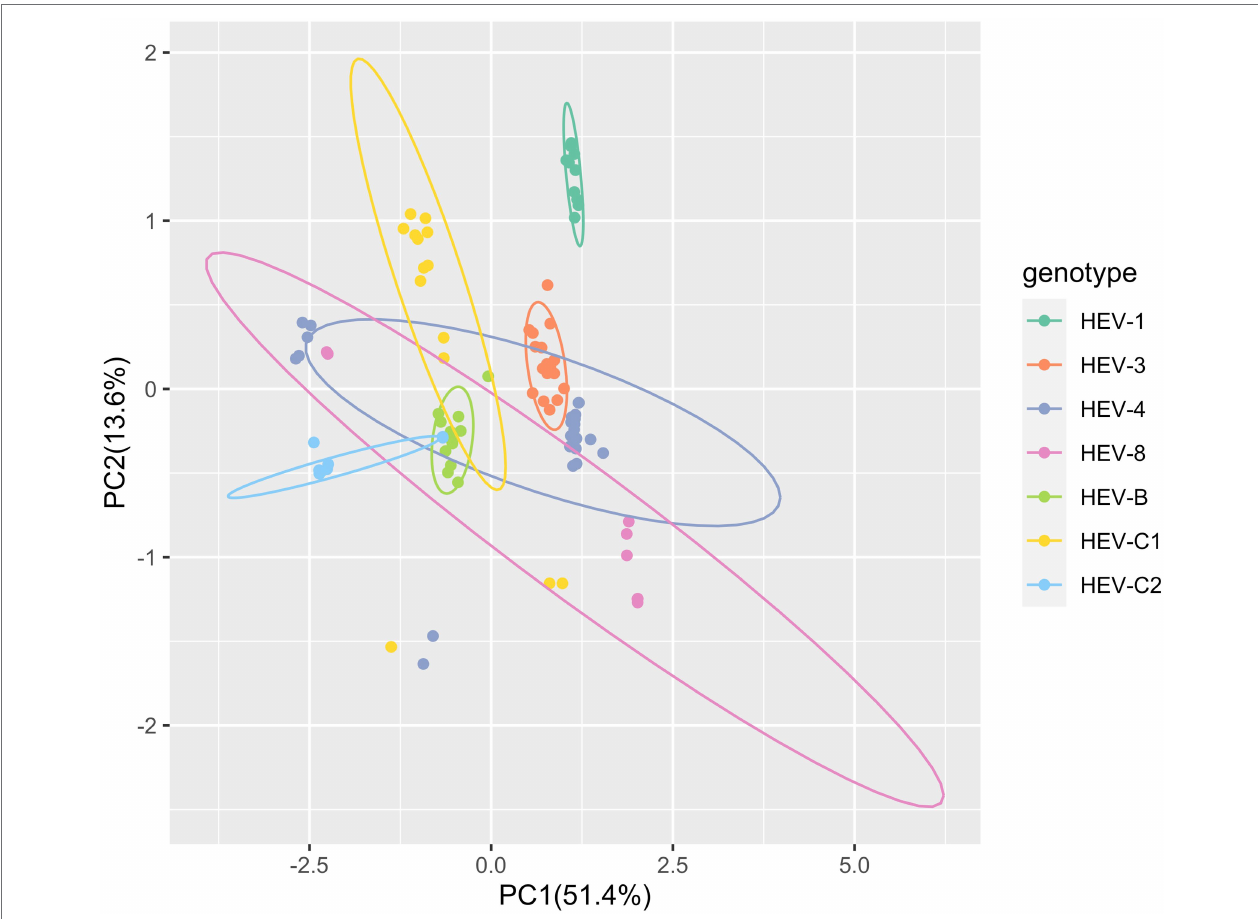
FIGURE 1 | Principal component analysis (PCA) based on the hepatitis E virus (HEV) complete coding sequences. The first dimension was plotted against the second dimension. PCA plot showed the deviations and similarity among the 59 synonymous codons of 98 HEV sequences included in the study. Seven HEV genotypes were presented by colors. The ellipses in the figure predicted new observations with a probability of 0.95. New observations from the same group were expected to fall inside the